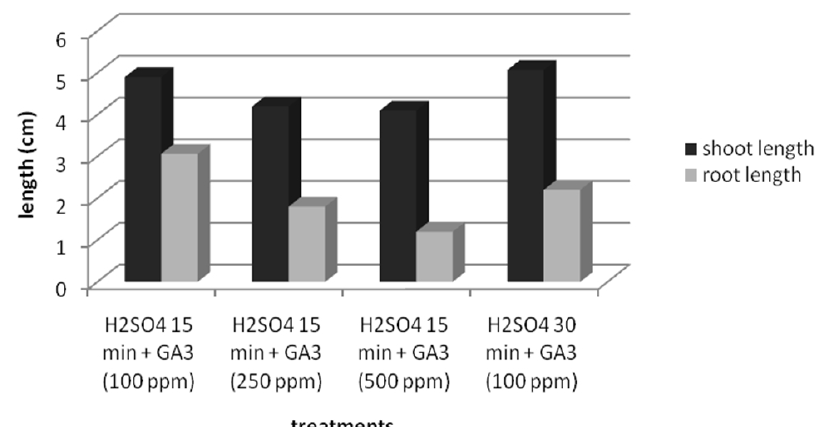
Fig. 2. Effect of combined dormancy breaking treatments on shoot and root length of Colutea bohsei seeds in laboratory conditions in the end of Tab. 2. Effect of various dormancy breaking treatments on germination percentage and germination rate of Colutea bohsei Boiss. seeds in laboratory conditions Treatments Control (no treatment) 7.5 h 1.5 gh